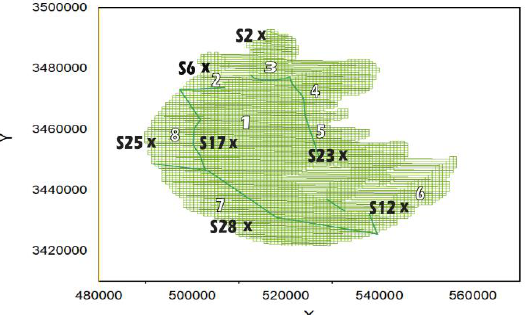
Figure 1. Eutrophic Lake Taihu in its grid form. Zones: (1) Central Zone, (2) Zhushan Bay, (3) Meiliang Bay, (4) Gonghu Bay, (5) East Epigeal Zone, (6) DongTaihu Bay, (7) Southwest Zone, (8) Northwest Zone, and data recording stations (S).